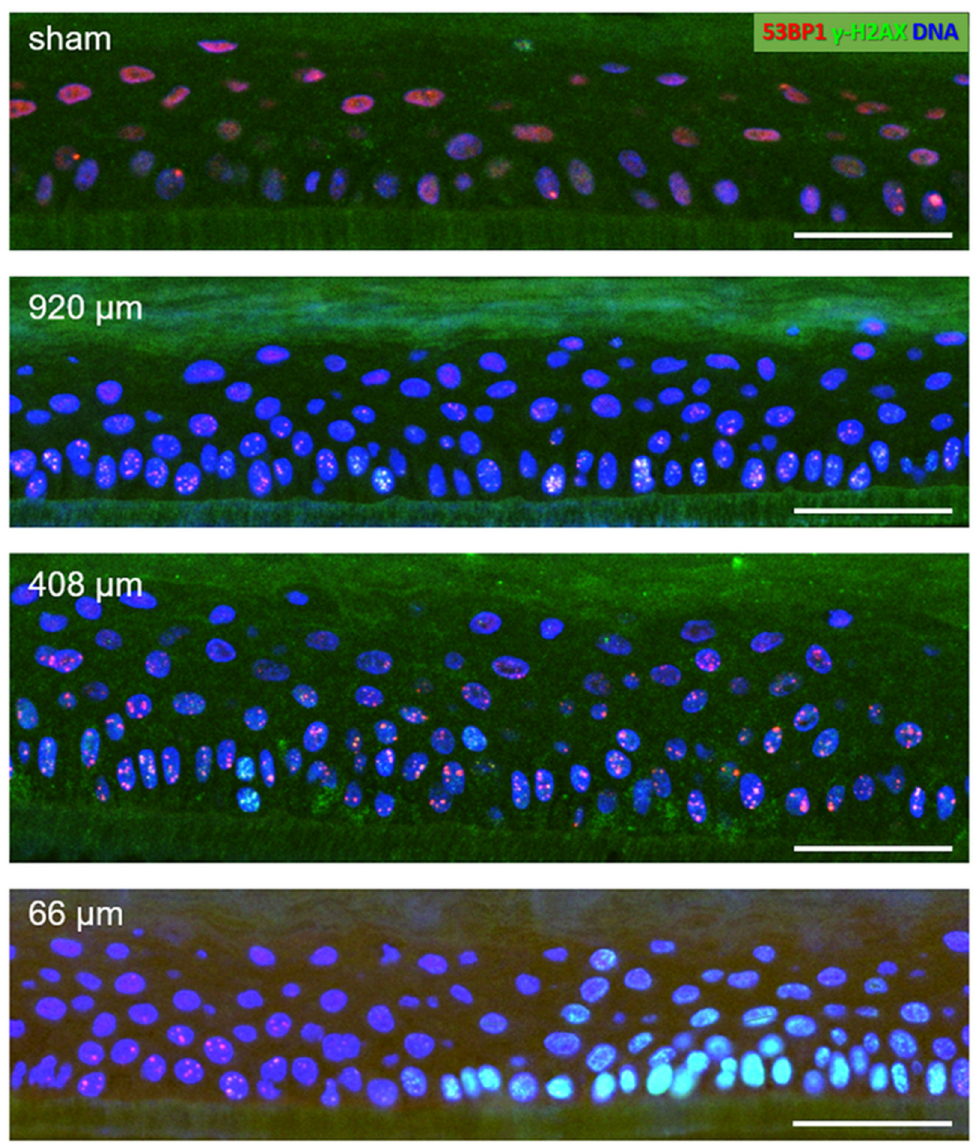
Figure 4. DNA damage in details of epidermis model cross-sections 6 h post-pMBRT. Sham-irradiated epidermis model: few nuclei (DAPI-stained blue) display one or two large 53BP1 foci (red) in the basal layer cells located on the support membrane (dark greenish layer) at the bottom of the images. The reddish diffuse nuclear 53BP1 signal stems from dispersed protein in nuclei without DSBs. 920 µ m minibeam irradiated model: Numerous cells showing colocalizing red 53BP1 + green γ -H2AX nuclear DSB foci (yellowish), which is particularly evident in the cells of the basal layer at the bottom of the image. 408 µ m minibeam irradiated model: Numerous cells showing colocalizing 53BP1 + γ